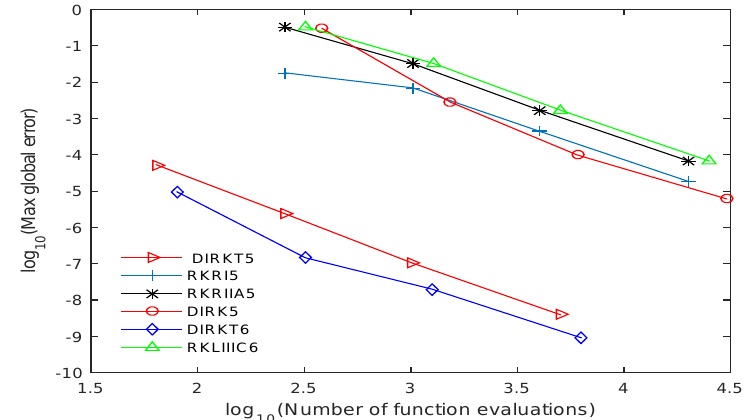
Figure 3. Accuracy curve for Problem 3 for DIRKT5, DIRKT6, DIRK5, RKRI5, RKRIIA5 and RKLIIIC6 methods with h = 0.1,0.025,0.00625,0.00125.